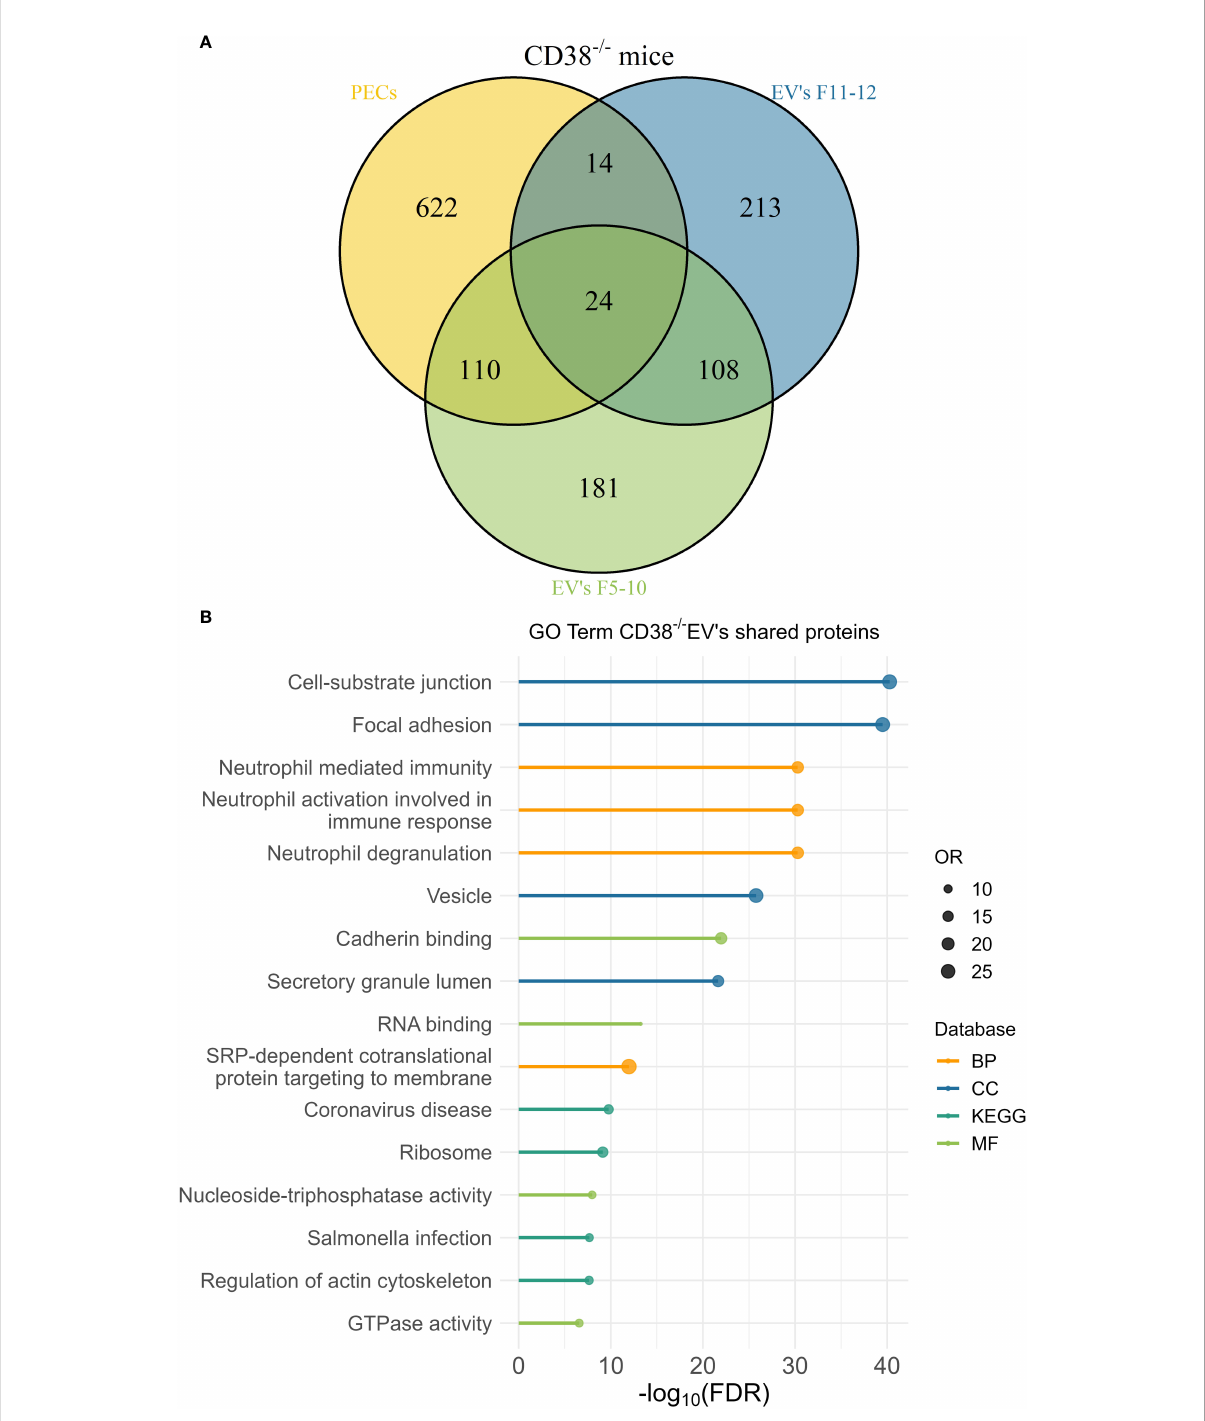
FIGURE 12 (A) Venn ’ s diagram of the proteins identi fi ed in Cd38 -/- PECs, F5-10 Cd38 -/- EV, and F11-12 Cd38 -/- EV. (B) Enrichment analysis of the proteins shared by Cd38 -/- PECs with F5-10 and F11-12 Cd38 -/- EV. The EnrichR software was used as described in Material and Methods. The – log 10 (FDR) was calculated for each database (KEGG, Biological Process, Molecular Function and Cellular Component) and the top 4 terms per each data base was selected to display in the